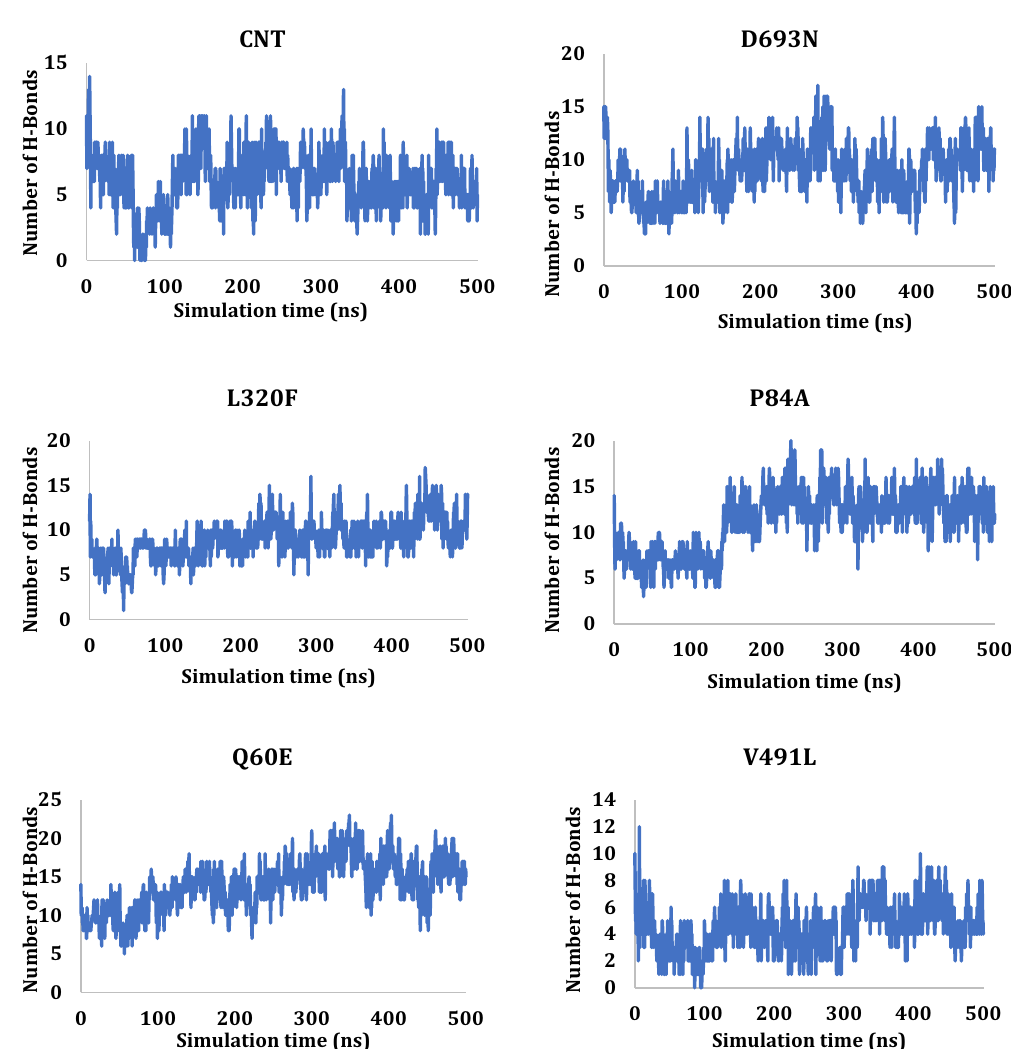
Figure 11. H-bonds interactions between the SARS-CoV-2 Spike and ACE 2 during